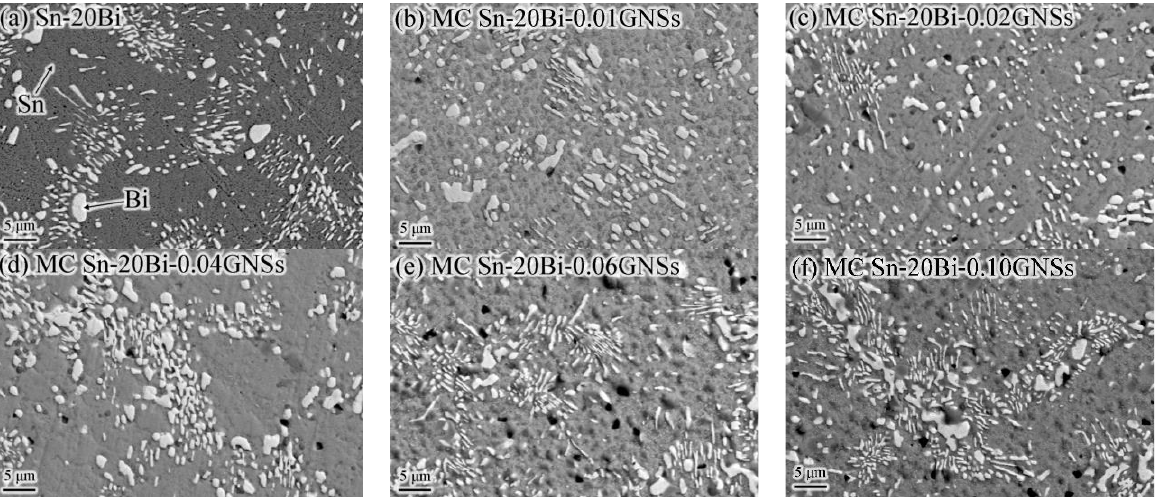
Figure 3. SEM images of MC Sn-20Bi- q GNSs alloys: ( a ) q = 0, ( b ) q = 0.01, ( c ) q = 0.02, ( d ) q = 0.04, ( e ) q = 0.06, and ( f ) q = 0.10.